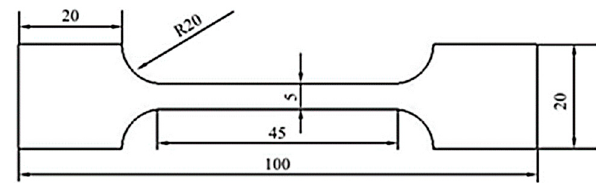
Figure 4. Schematic diagram of the tensile sample size. unit: mm.